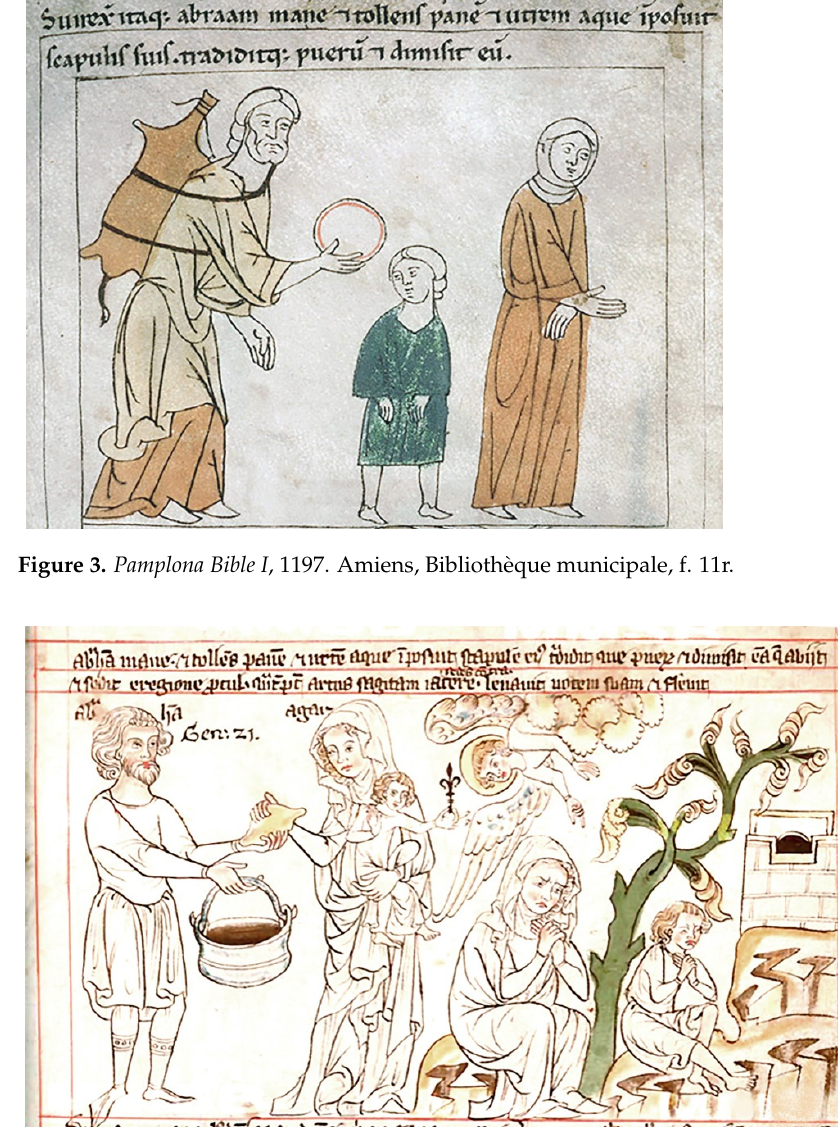
Figure 4. Velislaus Bible , mid-14th century. Prague, Národní knihovny Č R, XXIII.C.124, f. 21r.